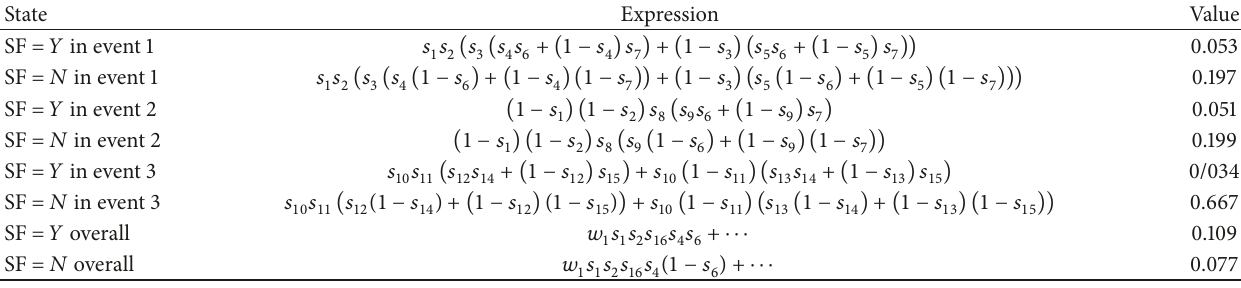
Table 5: Target state probability in US